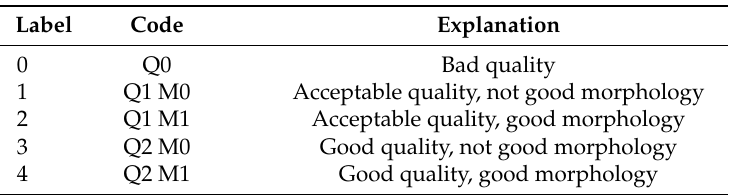
Table 1. Annotation